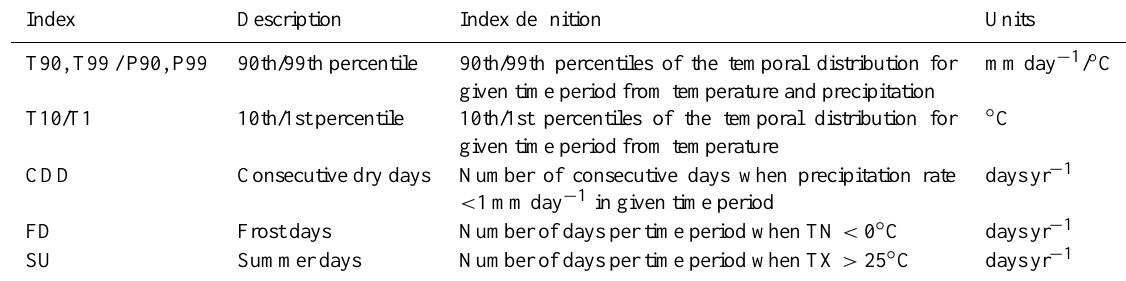
Table 1. Climate extreme